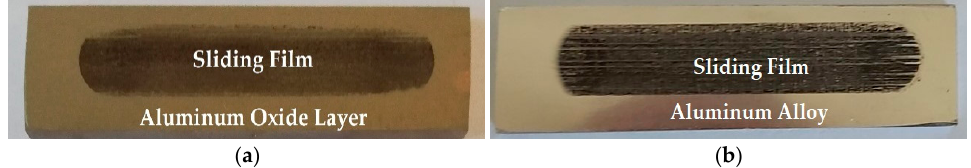
Figure 8. The surfaces of samples with a sliding foil applied as a result of tribological tests: ( a ) Sam- ple B, ( b ) sample